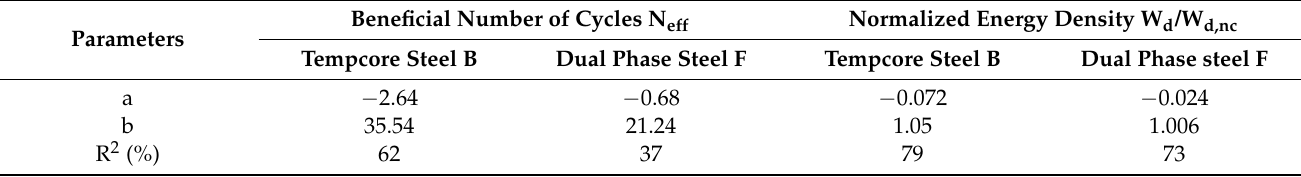
Table 10. Parameters determined by regression analyses for both types of steel reinforcement.